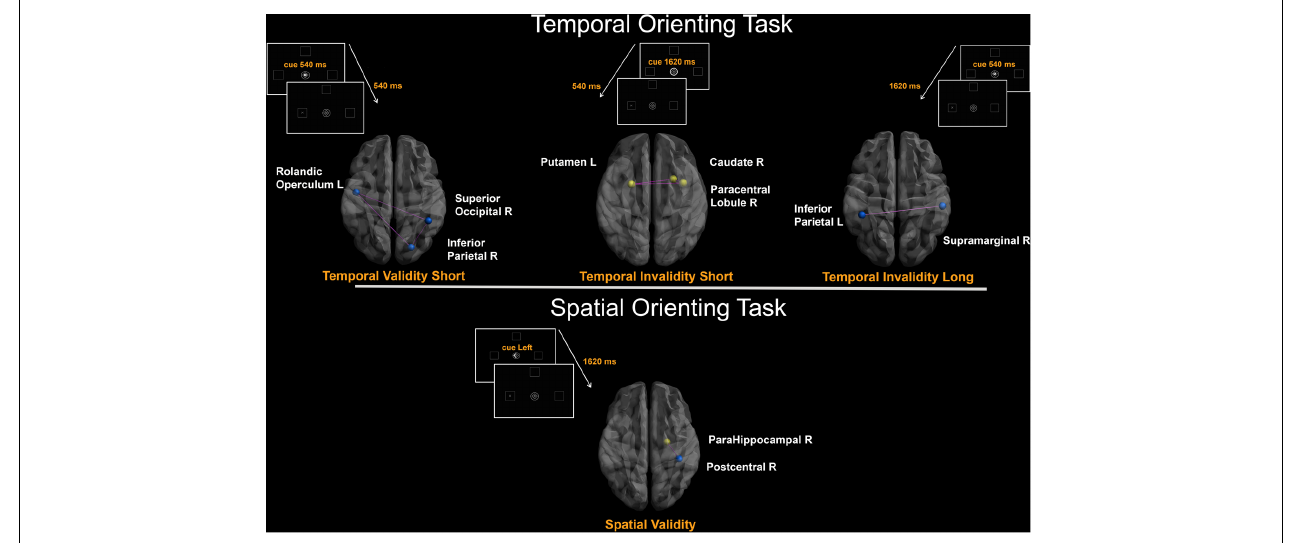
FIGURE 2 | Degree-based connectivity networks for spatio-temporal predictive performance. Brain areas’ local connectedness associated with subjects’ performance according to: (a) Temporal Validity short ; (b) Temporal Invalidity short ; (c) Temporal Invalidity long ; (d) Validity spatial indices. Nodes size represents the mean number of streamlines incident to each area; link size represents the R 2 value from the stepwise regression analyses. Blue = Negative correlation between performance and connectivity; Yellow = Positive correlation between performance and connectivity; Purple edges were drawn to represent links among areas.